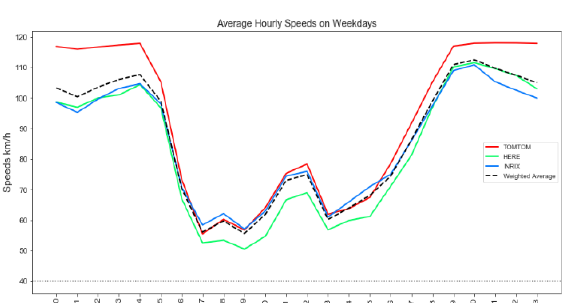
Figure 10: Time-of-day average speeds on weekdays for the entire road section.